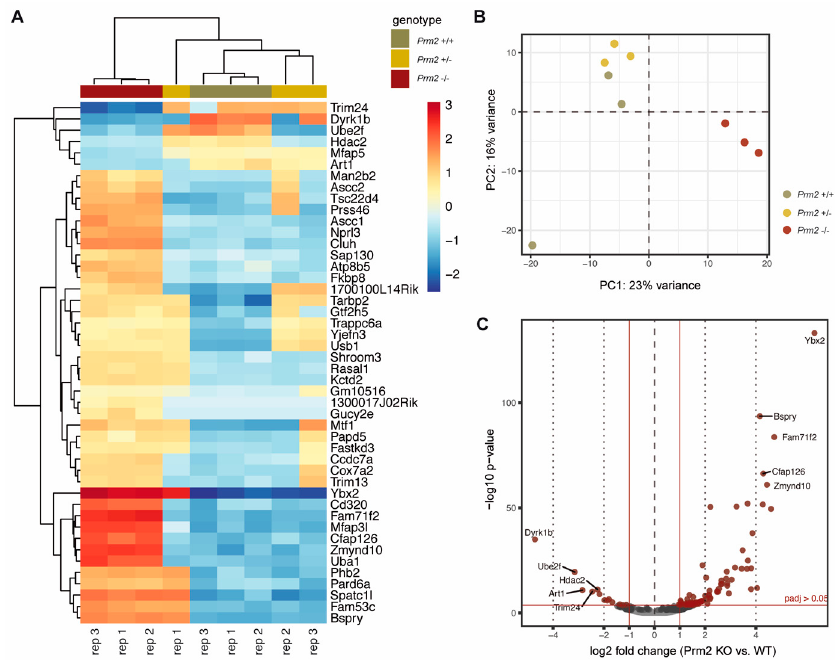
Figure 6. Changes in the testicular gene expression profile of Prm2 -deficient mice. ( A ) Heatmap visualization of the top 50 DE genes ( Prm2 − / − vs. Prm2 +/+ ) obtained by RNAseq on Prm2 +/+ , Prm2 +/ − and Prm2 − / − testes. Three biological replicates (rep) were analyzed per genotype. ( B ) Principal component analysis (PCA). ( C ) Volcano plot displaying DE expressed genes ( Prm2 − / − vs. Prm2 +/+ ) (adjusted p-value < 0.05, log 2 fold change (LFC) > 0.5) between Prm2 +/+ and Prm2 − / − testes.